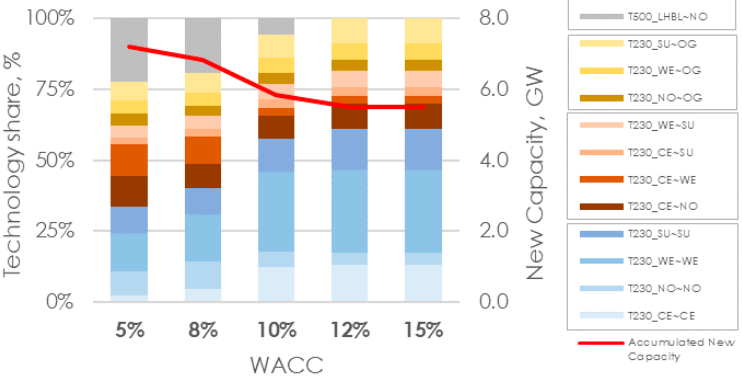
Figure 6. Accumulated new transmission capacity 2013–2040 for all WACC scenarios.